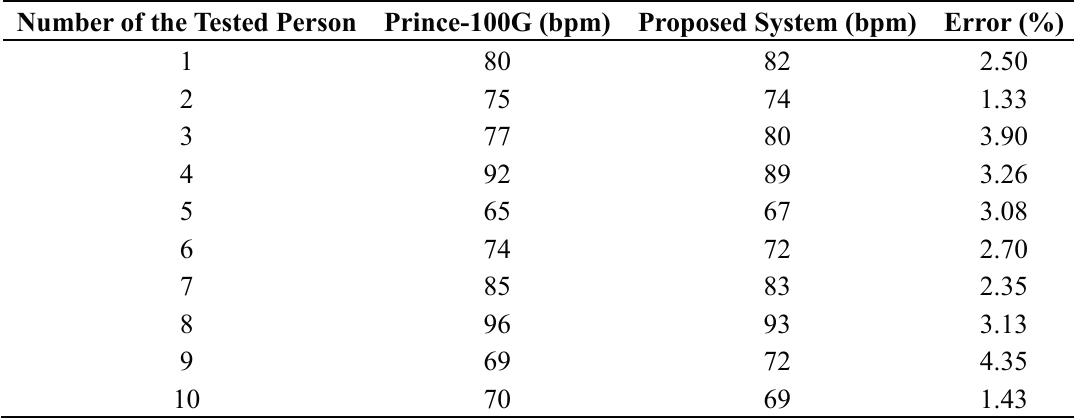
Tables 3. Results of